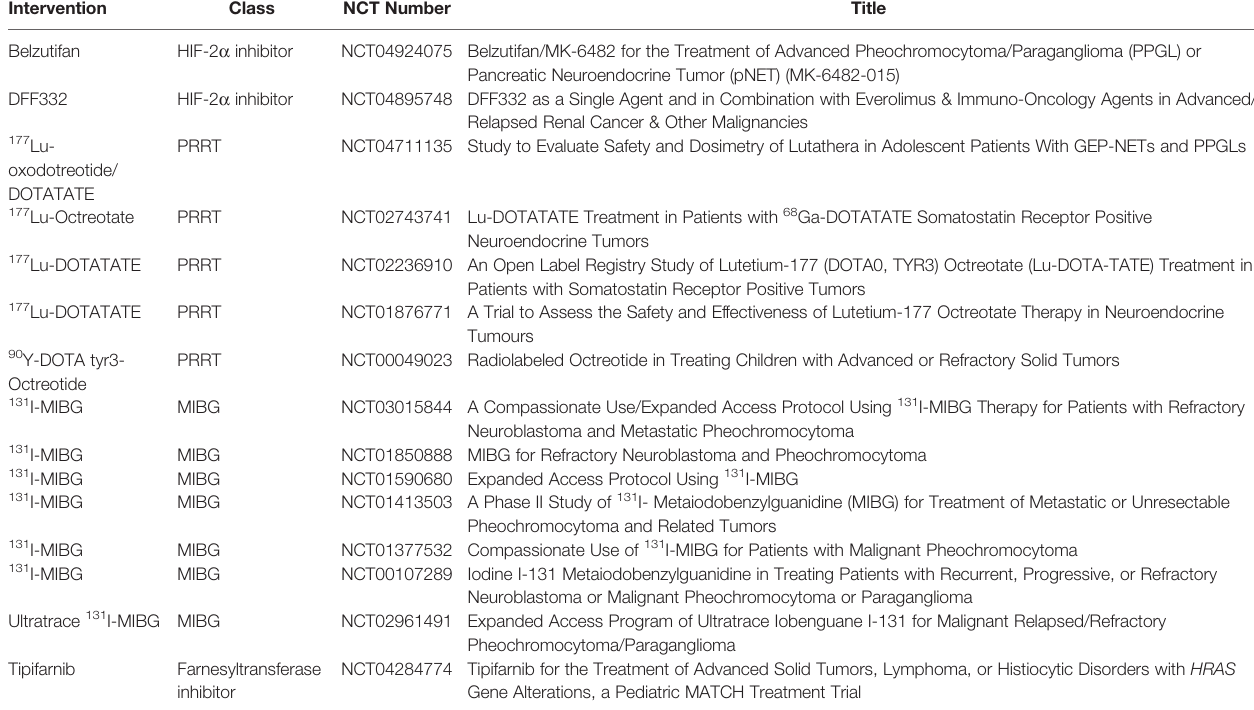
TABLE 4 | Clinical trials for metastatic PPGL therapies in pediatric patients that are recruiting, active, or approved.